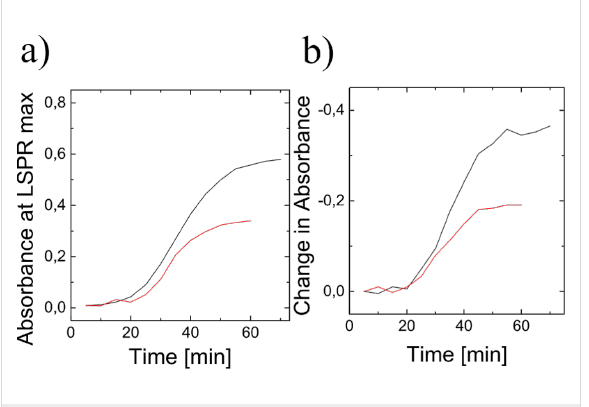
Figure 5: Time evolvement of the extinction spectrum during the for- mation of silver nanoparticles. The increase of the plasmon related peak at 420 nm (Figure 5a) correlates with the decrease of the peak at 270 nm related to Ag 42+ clusters (Figure 5b). Red and black curves represent different ratios of AgNO 3 solution and orange